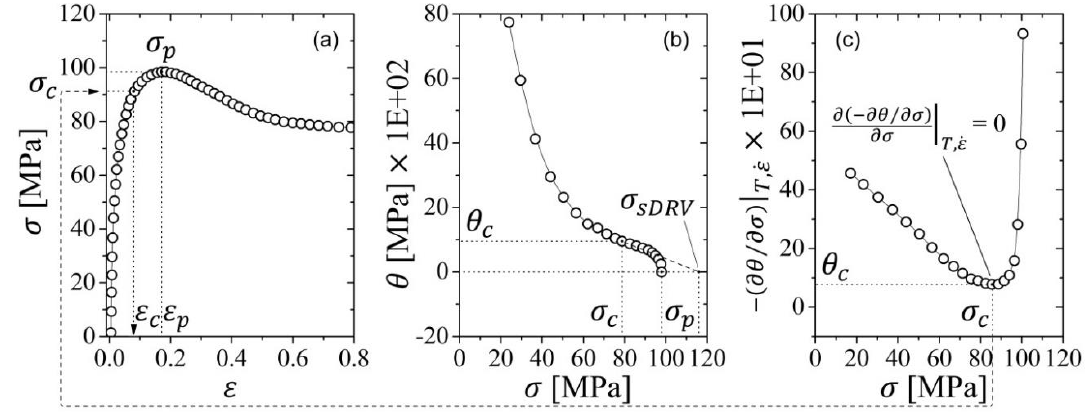
Figure 5. Schematic of the Poliak–Jonas procedure to determine ε c ( a ) flow curve, ( b ) corresponding work hardening rate θ vs stress and ( c ) first derivative of the work hardening rate θ vs stress [14,29].